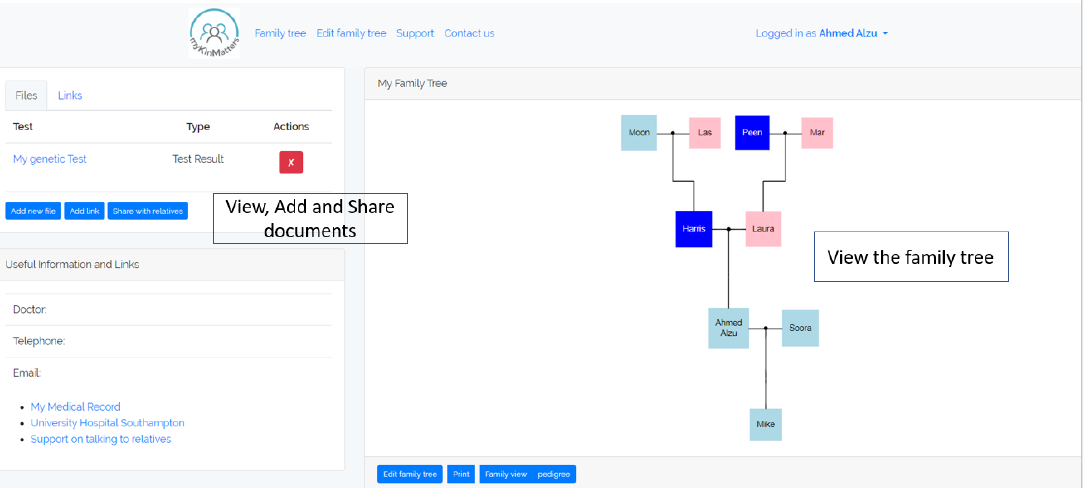
Figure 1. myKinMatters provides patients and clinicians with the ability to view genetic information and choose the data sharing policies that are appropriate for the individual, their family and medical